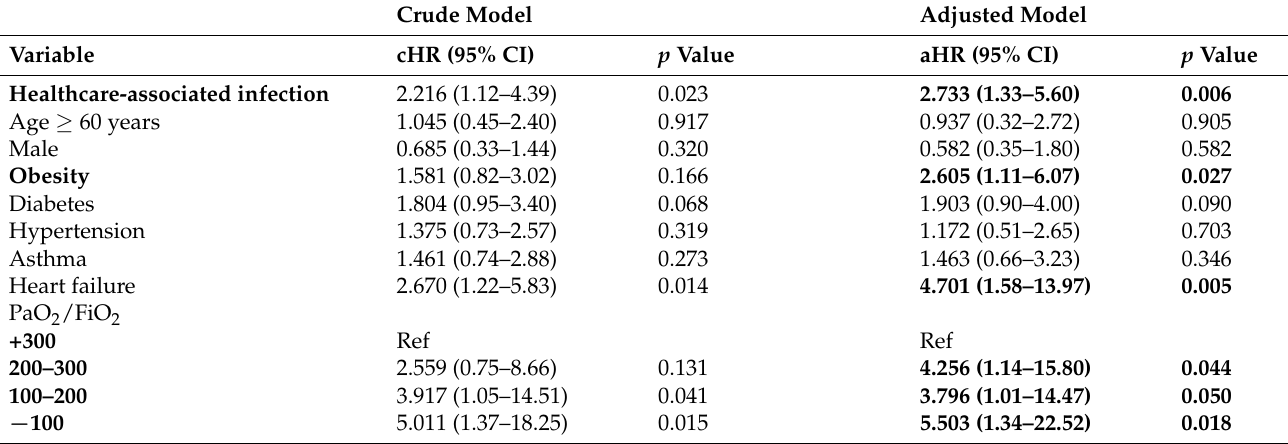
Table 4. Cox regression analysis to evaluate predictors of mortality in patients hospitalized for critical COVID-19.